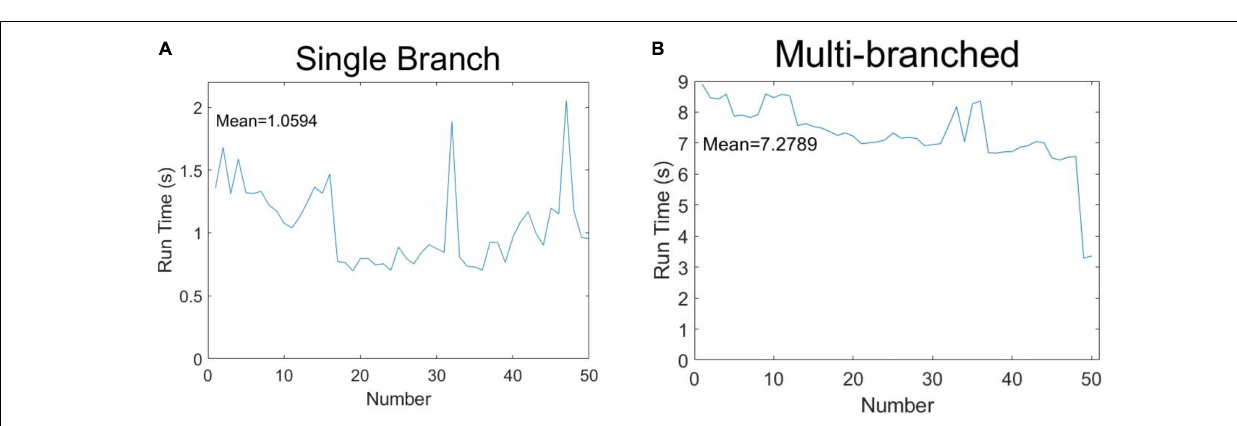
a value slightly larger than 7.8530 ◦ is selected. In this paper, we opted to judge the branch according to the error angle of the lower half of the stem node and selected an error angle of 10 ◦